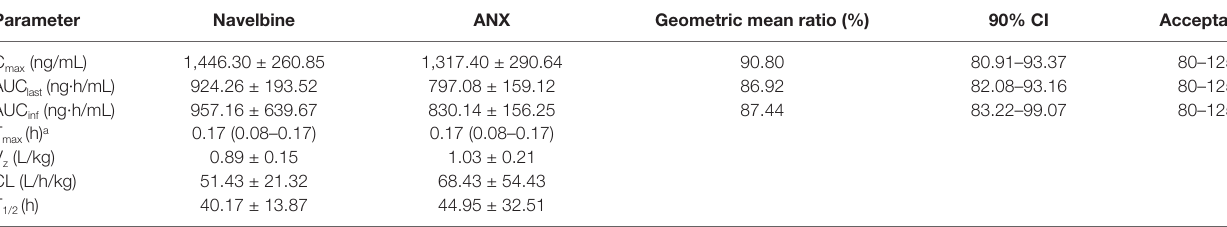
TABLE 3 | Pharmacokinetic results for the two vinorelbine products.